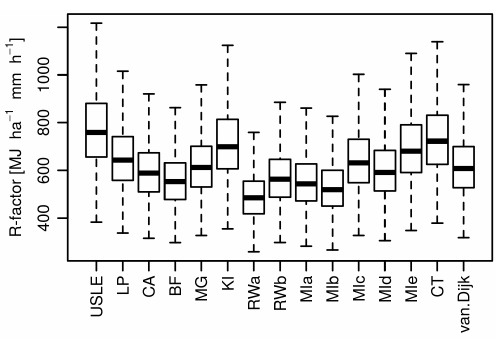
Figure 5. Estimated R factor (MJha − 1 mmh − 1 ) considering dif- ferent kinetic energy formulations (see Appendix